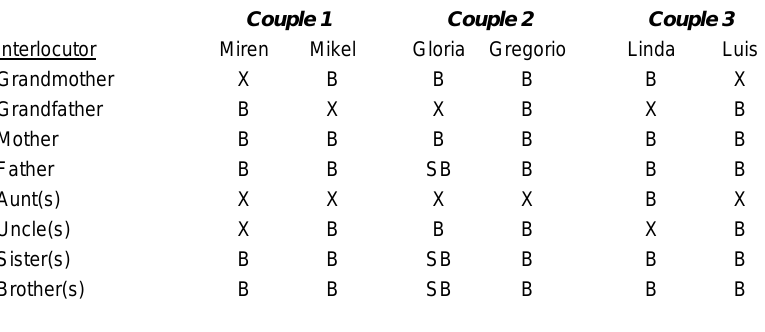
Table 1: Language Use at Home